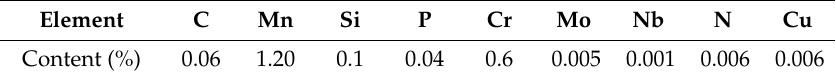
Table 2. Chemical composition (wt %) of DP600.